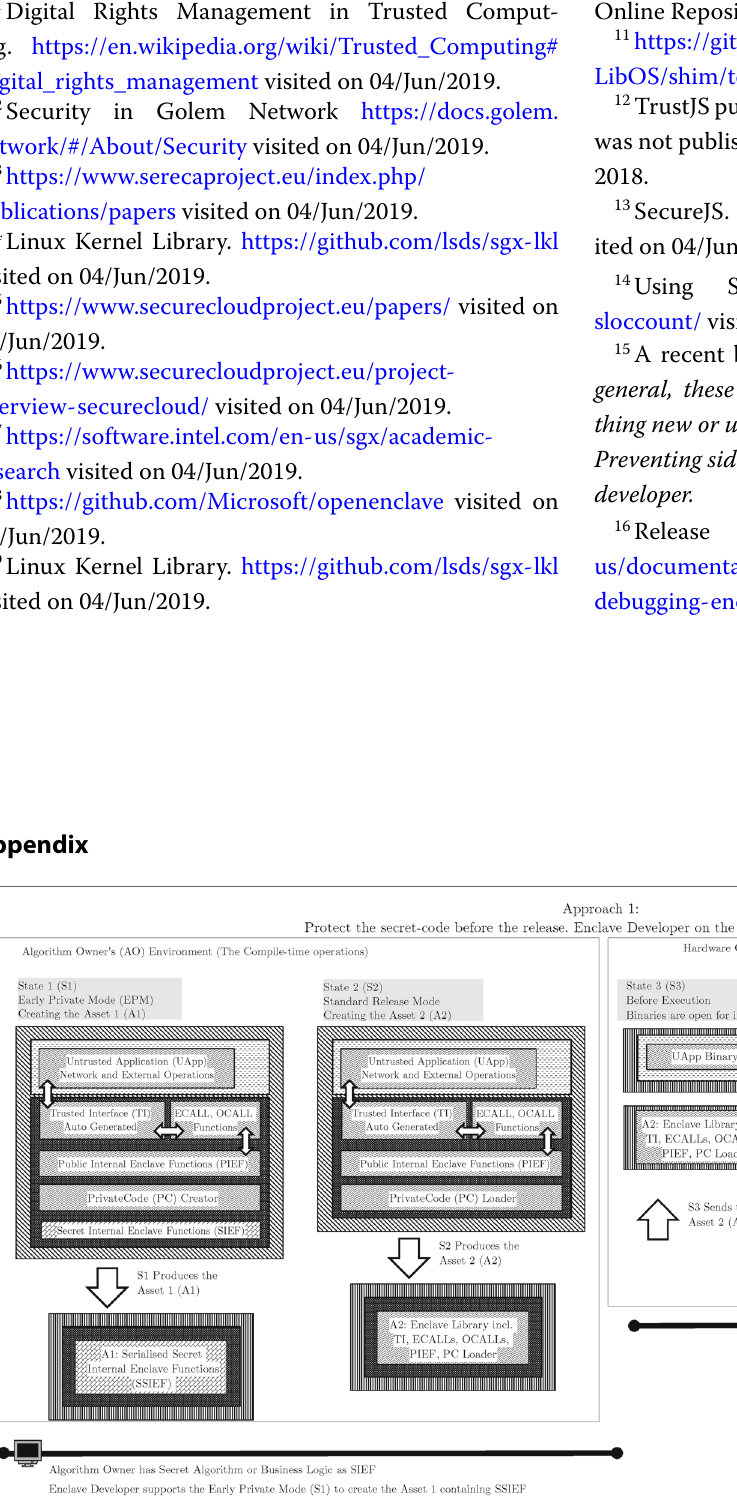
Fig. 12 Secret-Code Execution (SCE) in Reduced TCB. Enabling the use of private algorithms inside SGX enclaves. Extend the enclave partitioning with private and public parts. The private part is processed in an early stage before the release of the